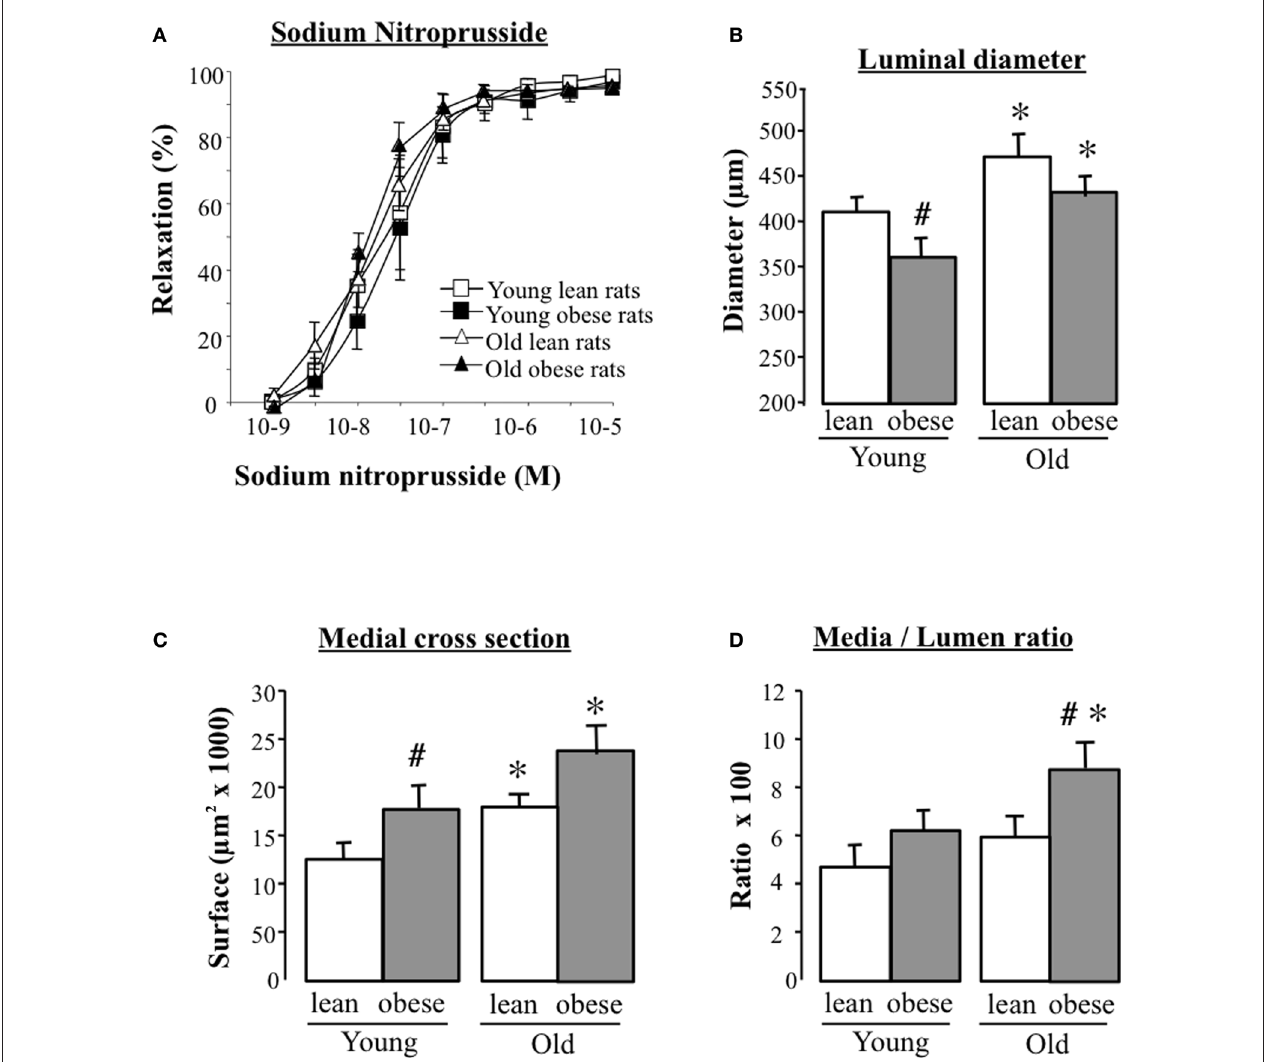
Figure 2 | sodium nitroprusside-mediated relaxation in mesenteric arteries isolated from lean and obese Zucker rats aged 3 (young) or 12 months (old) (A). Luminal diameter, media cross-section, and media/lumen ratio are shown in (B–d) respectively. Mean ± SEM is presented ( n = 8 per group). * P < 0.01, old versus young rats. # P < 0.01, obese versus lean